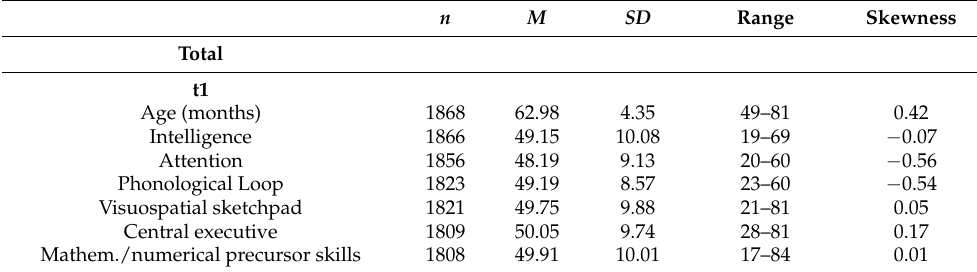
Table 3. Descriptive